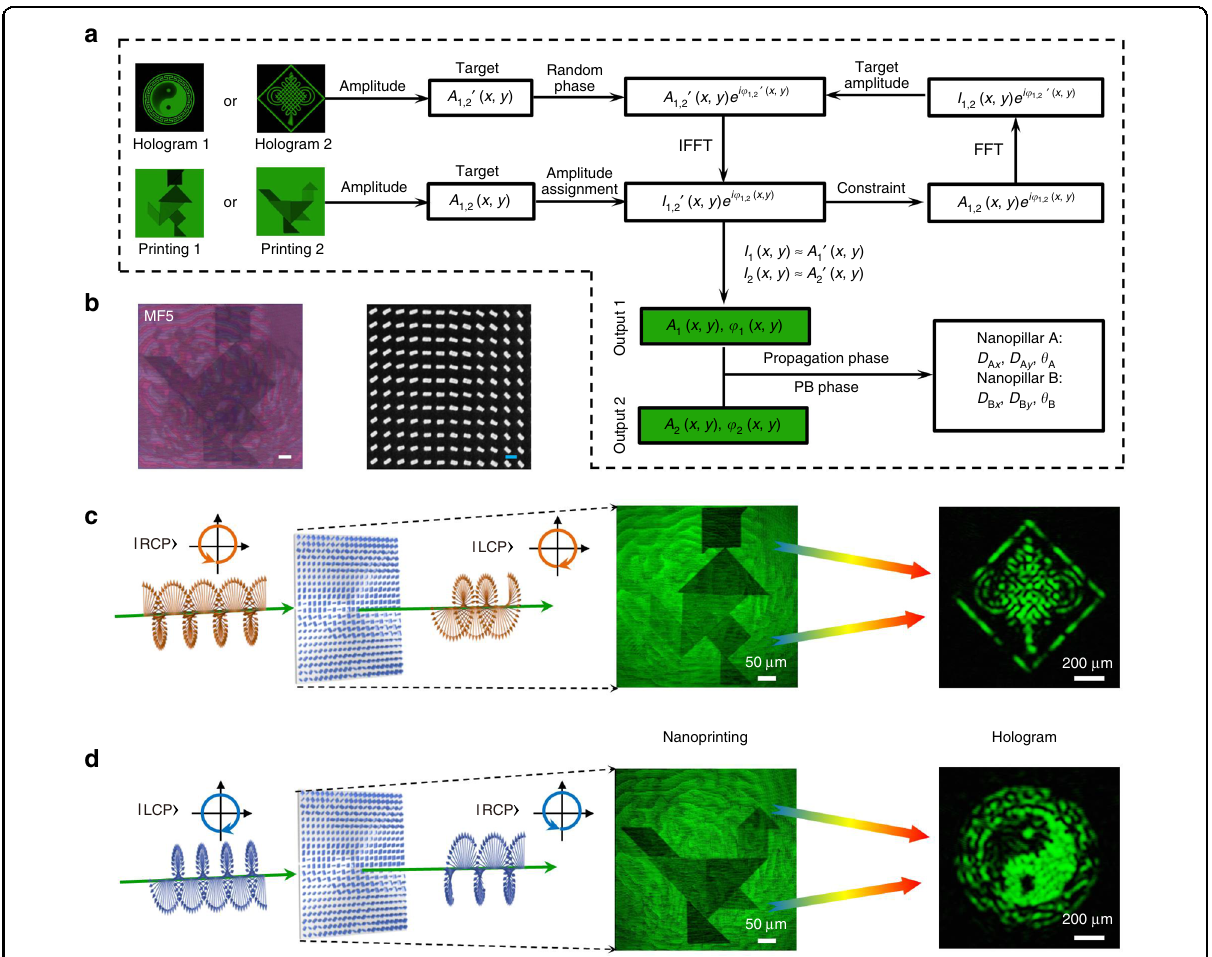
Fig. 5 Synchronous generation of four-channel nanoprinting hologram using a metasurface device. a Design fl ow chart of a modi fi ed Gerchberg – Saxton algorithm for polarization-dependent synchronous nanoprinting-hologram generation using a metasurface. b Left: optical microscope image of the fabricated metasurface device MF5. Scale bar: 50 μ m. Right: SEM image of MF5. Scale bar: 500 nm. c , d Experimental results of generation of four-channel nanoprinting-hologram images: nanoprinting images of “ person ” (RCP) and “ bird ” (LCP) near the metasurface, and hologram images of “ Chinese knot ” (RCP) and “ Eight Trigram ” (LCP) in the far fi